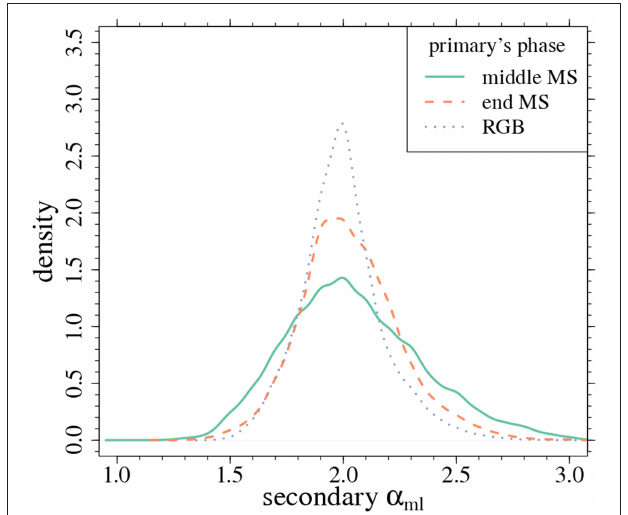
FIGURE 5 | Distribution of the expected differences between the recovered mixing-length values of the primary and secondary star, when both stars in the synthetic systems have common α ml =